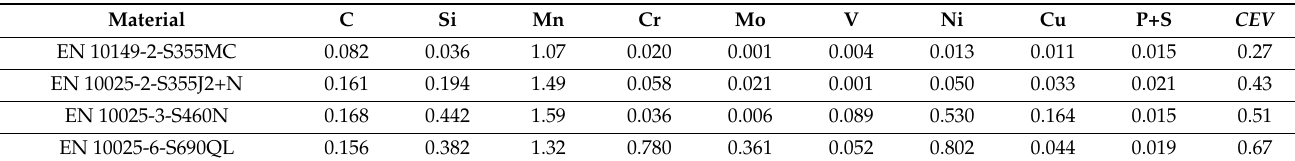
Table 2. Chemical compositions of materials studied, in wt%.